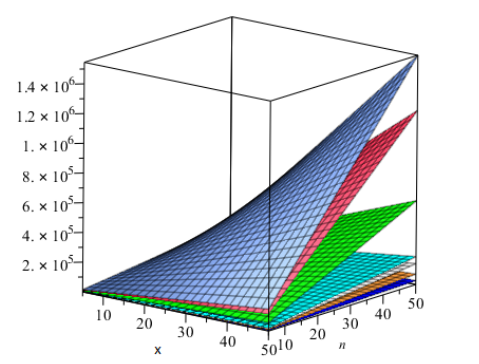
Figure 7: The comparison of all topological indices for HDN 1( n ) .